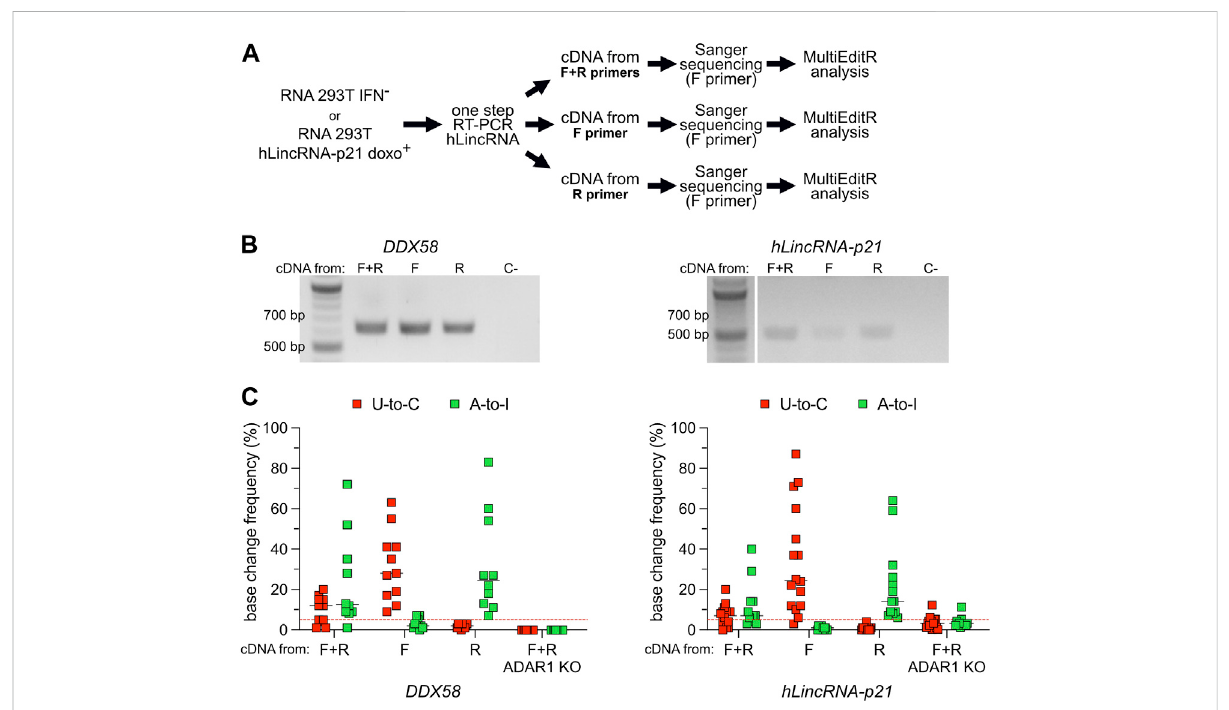
FIGURE 4 U-to-C base changes originate from A-to-I RNA editing on antisense RNA. (A) Flowchart of the experiment. (B) Representative agarose gel of the ampli fi cation products of DDX58 and hLincRNA-p21 upon one-step PCR using different primers for cDNA synthesis. C- = negative control. (C) Dot plots showing the editing frequency in U-to-Cs and A-to-Is measured from Sanger sequencing dependent on the primer used for cDNA synthesis. Only sites with editing higher than 5% in at least one condition are plotted. Each dot = one single site; line = median; red dashed line represents the limit of detection of MultiEditR (Kluesner et al., 2021). U-to-Cs and A-to-Is are shown in red and green,